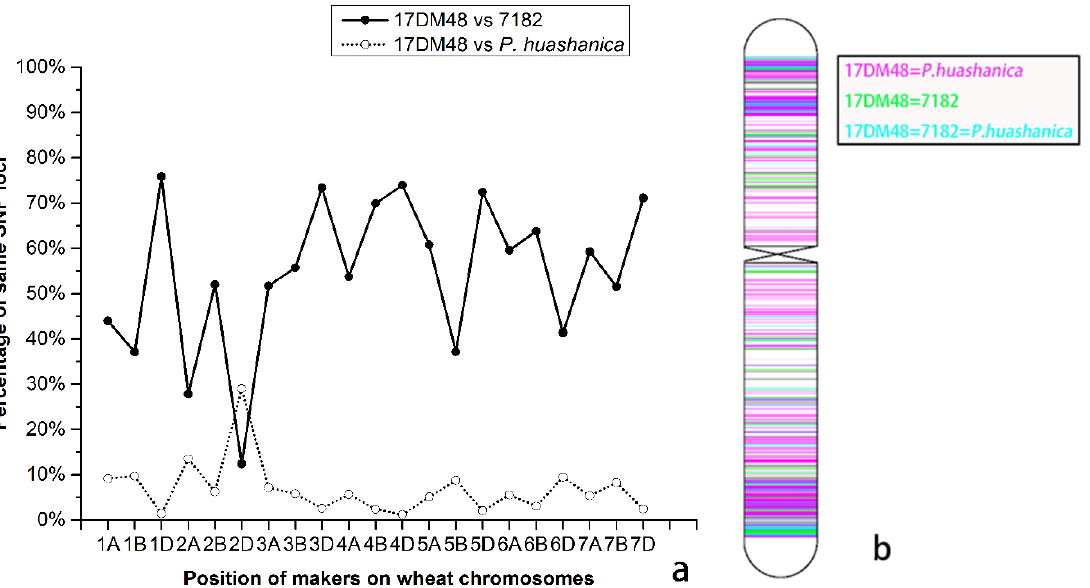
Figure 3. Wheat 55K SNP mapping analysis of 17DM48. ( a ) Obvious crossing point in terms of the position of the 2D chromosome. ( b ) Positions of the same SNP loci at the 2D chromosome in the genotype of 17DM48 with P. huashanica and line 7182.